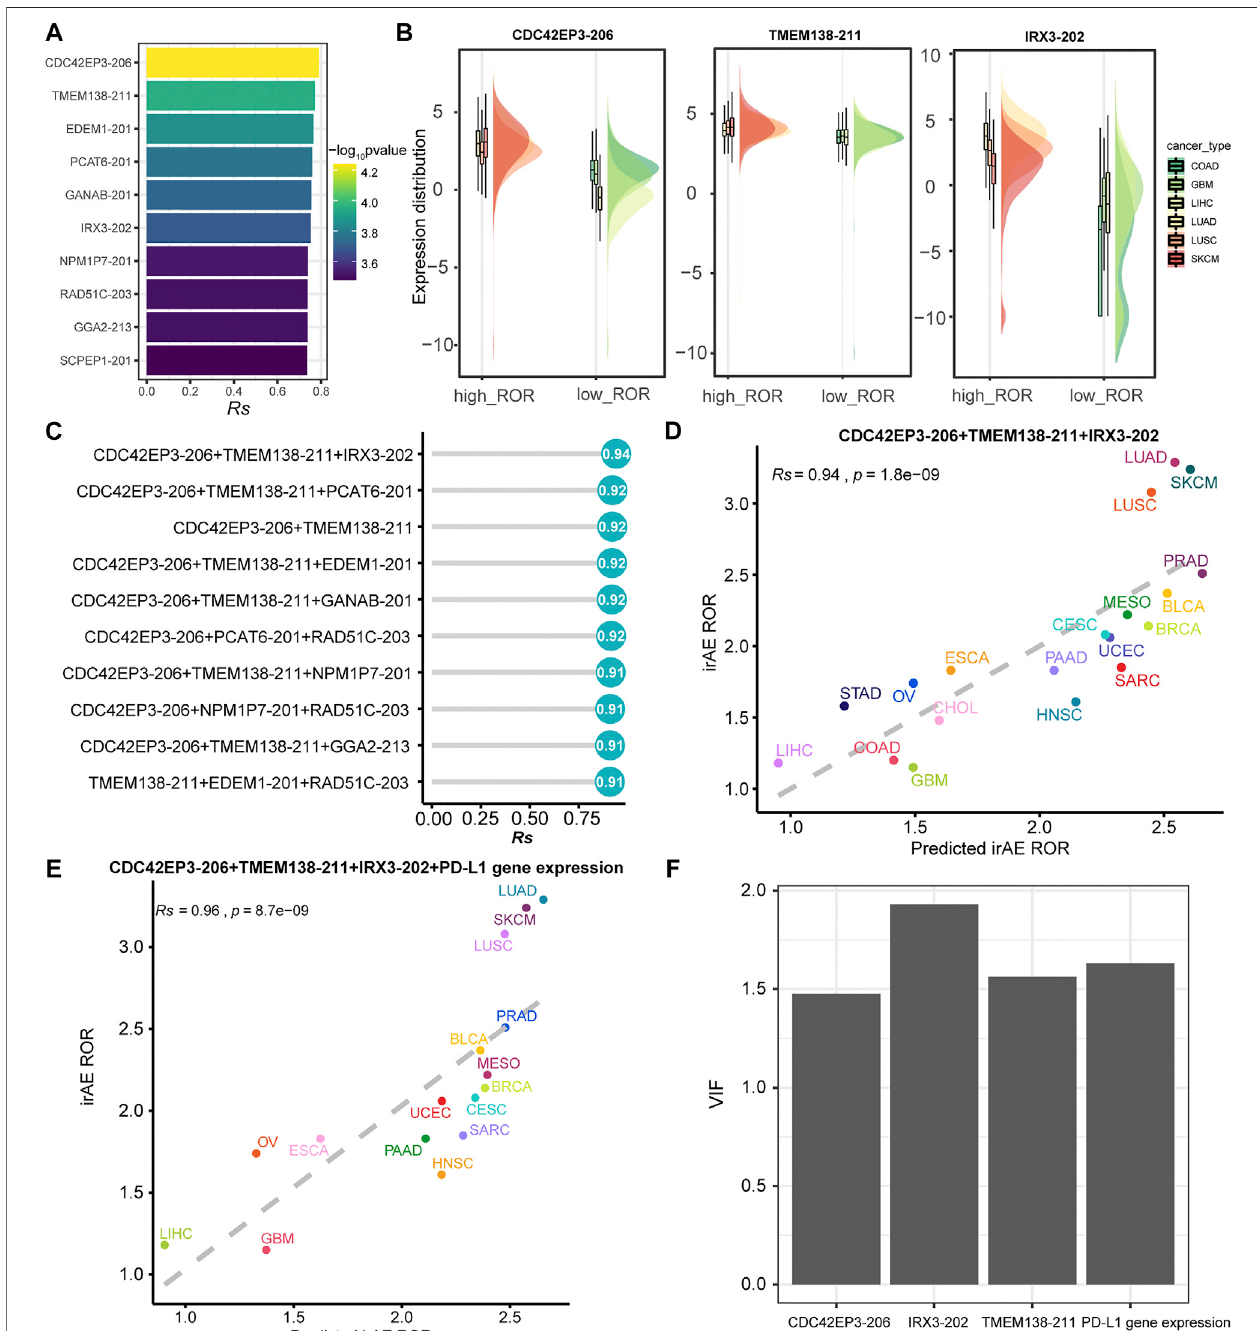
FIGURE 5 | Regression analysis for splicing isoforms to predict irAE risk. (A) The top ten splicing isoforms signi fi cantly correlated with irAE ROR across multiple cancer types. The bar represents Rs , and the color indicates the corresponding p value. (B) Expression distribution of representative splicing isoforms positively correlated to irAE in different TCGA cohorts. Boxplots represent log 2 (TPM+0.001) values for splicing isoforms. Within each TCGA cohort, the bottom and top of the boxes are the 25th and 75th percentiles (interquartile range), and the thick line represents the median value. The whiskers encompass 1.5 times the interquartile range. (C) Comparison of performance of bivariate and trivariate models in predicting irAE for all combinations of the top ten irAE ROR signi fi cantly correlated splicing isoforms. Rs was calculated between predicted and observed irAE ROR. (D) Combination of CDC42EP3-206, TMEM138-211, and IRX3-202 to predict irAE risk. The dot color represents the cancer type. The dashed line represents the linear fi t. (E) Combination of CDC42EP3-206, TMEM138-211, IRX3-202, and PD-L1 gene expression to predict irAE risk. (F) Multicollinearity assessment of the models fi tted using the Variance In fl ation Factor (VIF).